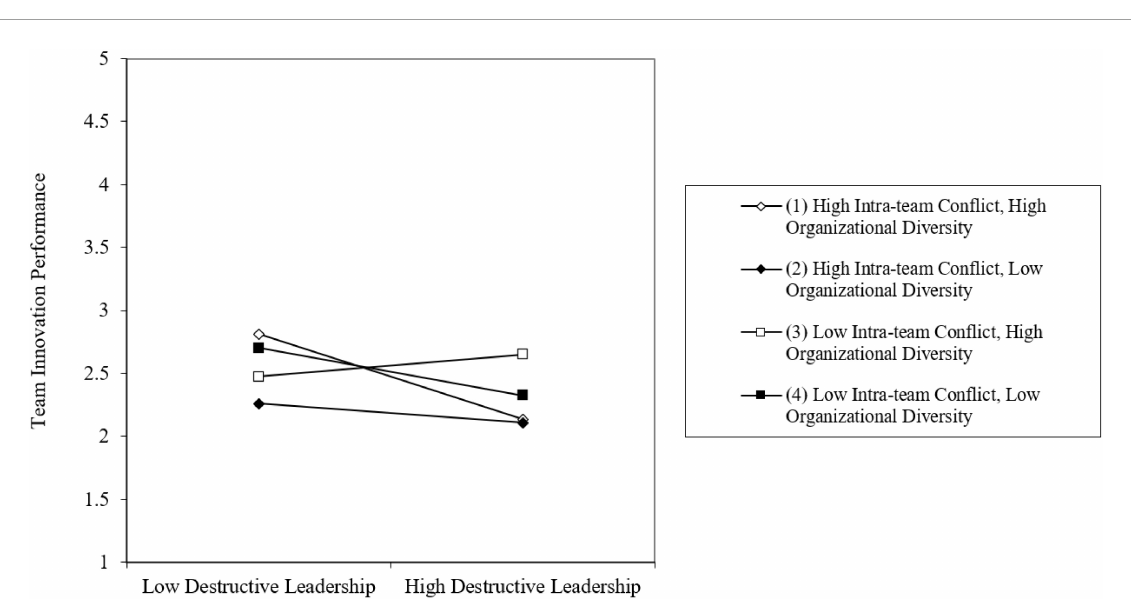
destructive leadership and team innovation